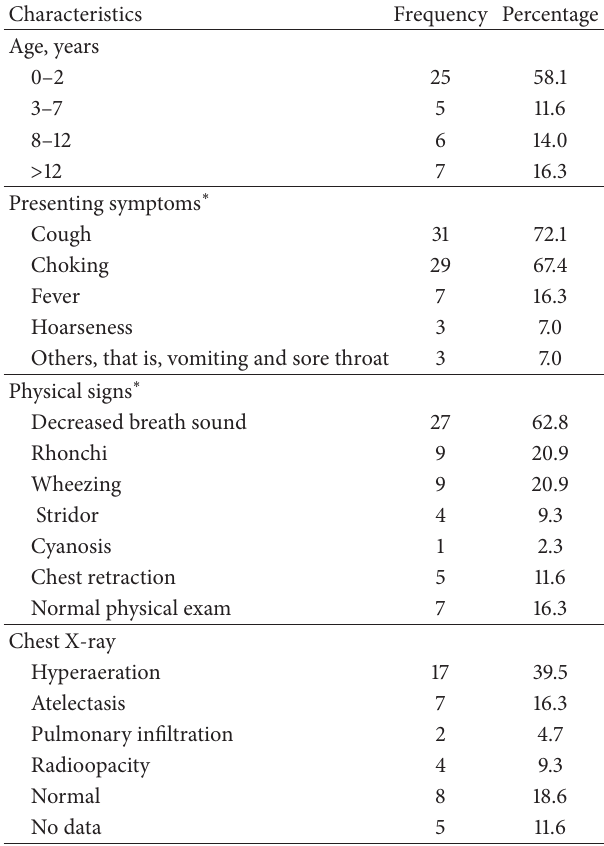
Table 1: Clinical characteristics of patients with foreign body aspi- ration ( 𝑛 = 43).